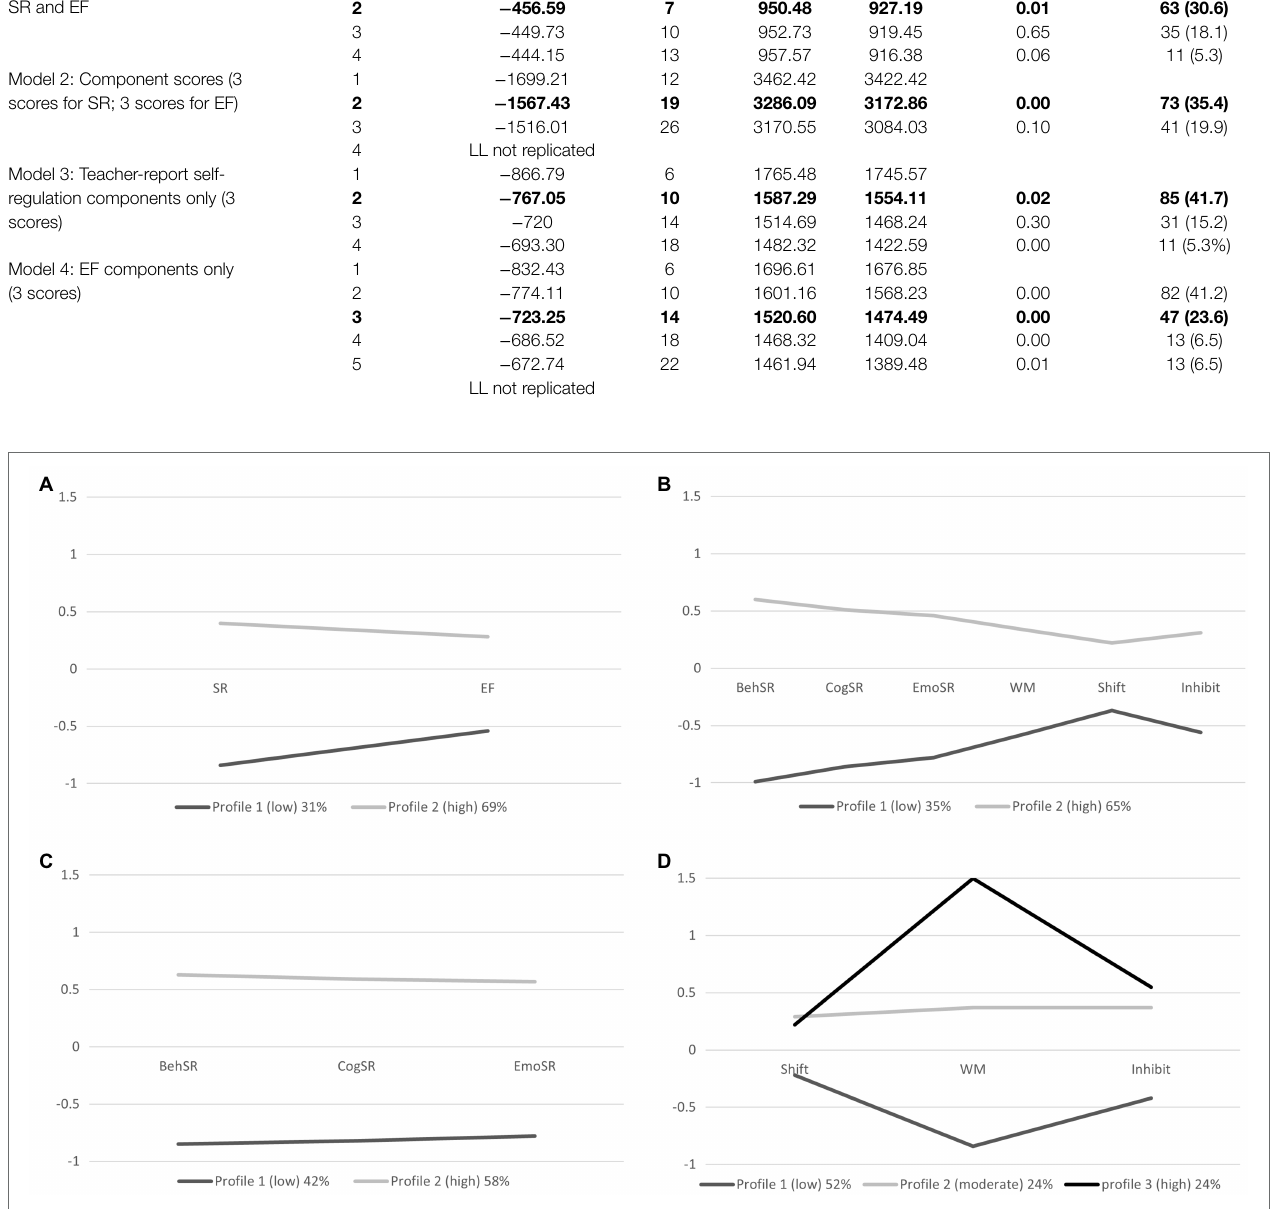
FIGURE 1 | Average indicator scores for profiles across four latent profile analysis models. (A) Model 1 of composite scores SR (yielded from three teacher- reported subscales) and EF (yielded from three direct assessments). (B) Model 2 of component items which include a total of three SR subscales and three EF measures. (C) Model 3 of three teacher-reported SR subscales only. (D) Model 4 of three directly assessed EF measures only. SR, self-regulation composite; EF, executive function composite; Beh SR, behavioral self-regulation; Cog SR, cognitive self-regulation; Emot SR, emotional self-regulation; WM, working memory; Shift, shifting; and Inhibit, inhibition.